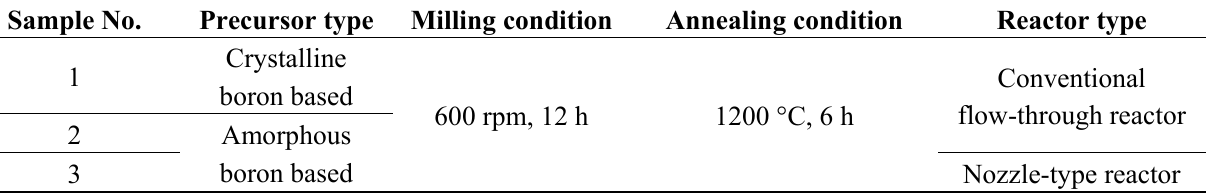
Table 1. Experimental schemes and conditions dependent on the reactor and precursor types.